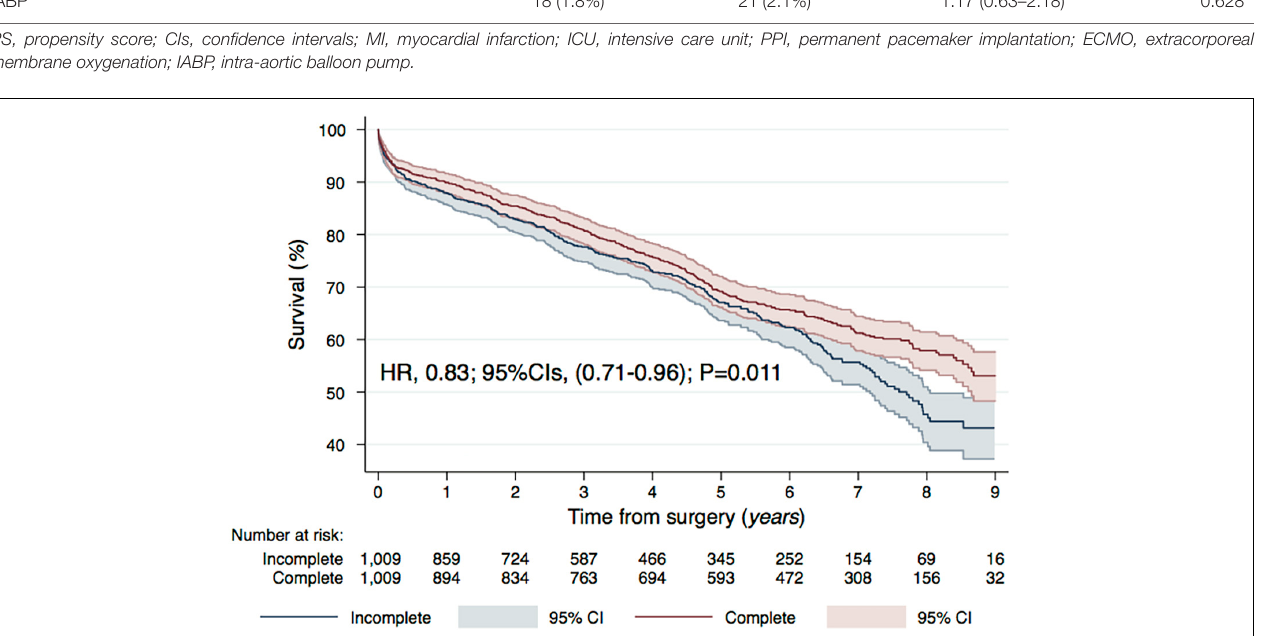
500 (49.6%) CR patients were operated on without the use of cardio-pulmonary bypass ( p = 0.182). As expected, the number of distal anastomoses varied between groups (1.7 ± 0.6 non-CR vs. 3.0 ± 0.6 CR, P < 0.001). Table 3 lists information regarding grafts and